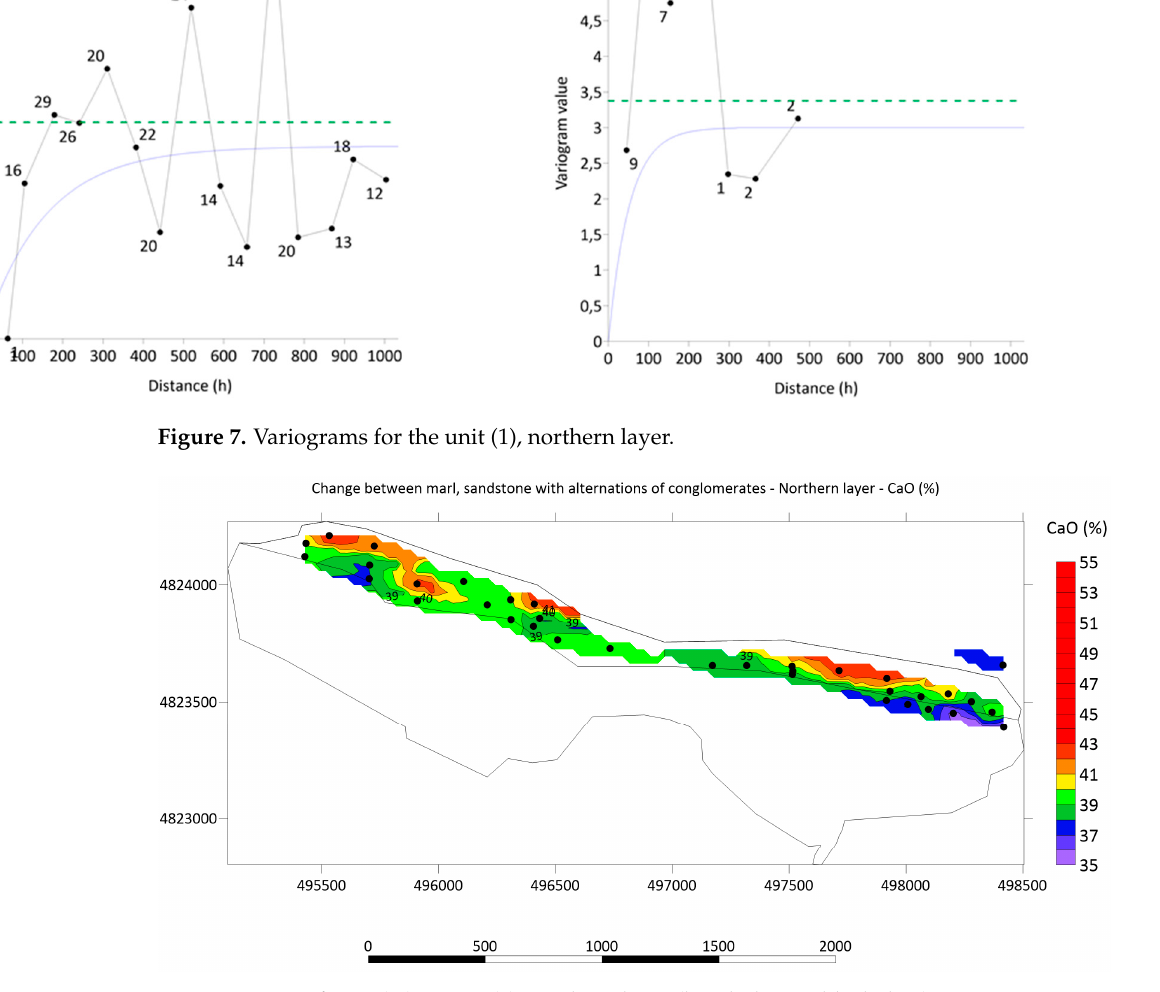
Figure 8. Map of CaO (%) in unit (1), northern layer (boreholes are black dots).